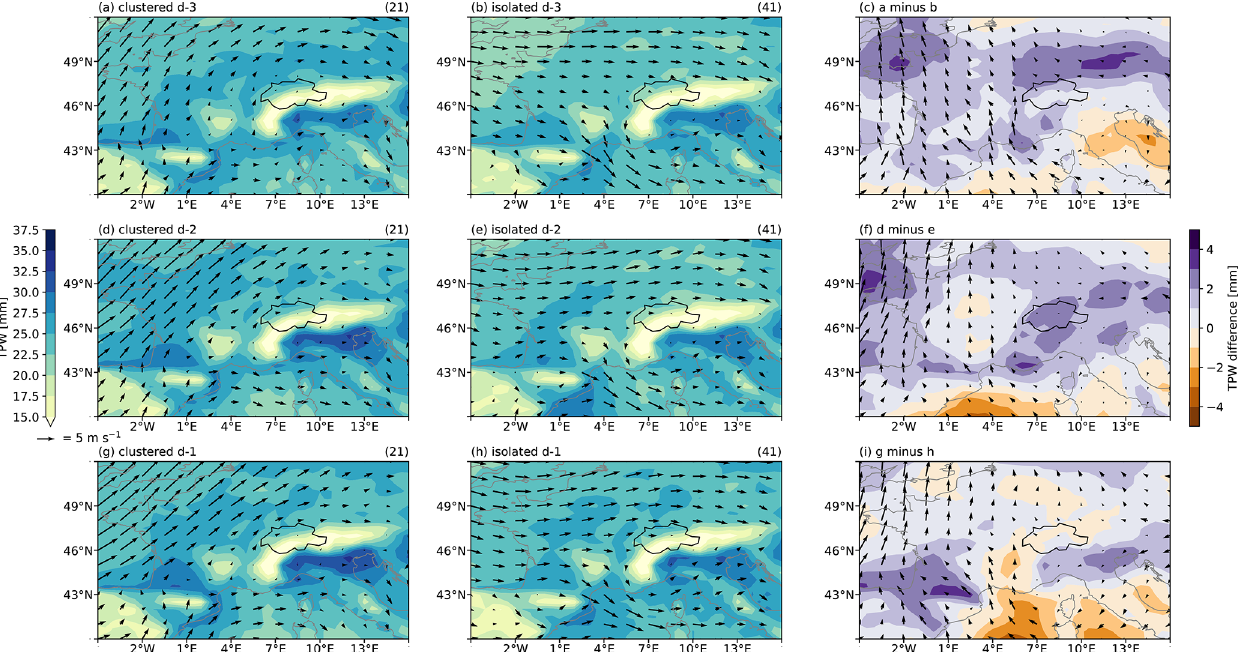
Figure 12. Composites of TPW (colored contours) and winds at 850hPa (vectors) for the 3d prior to clustered (a, d, g) and isolated (b, e, h) hail days south of the Alps. The differences are shown in panels (c) , (f) , and (i) . See caption of Fig. 5 for details.